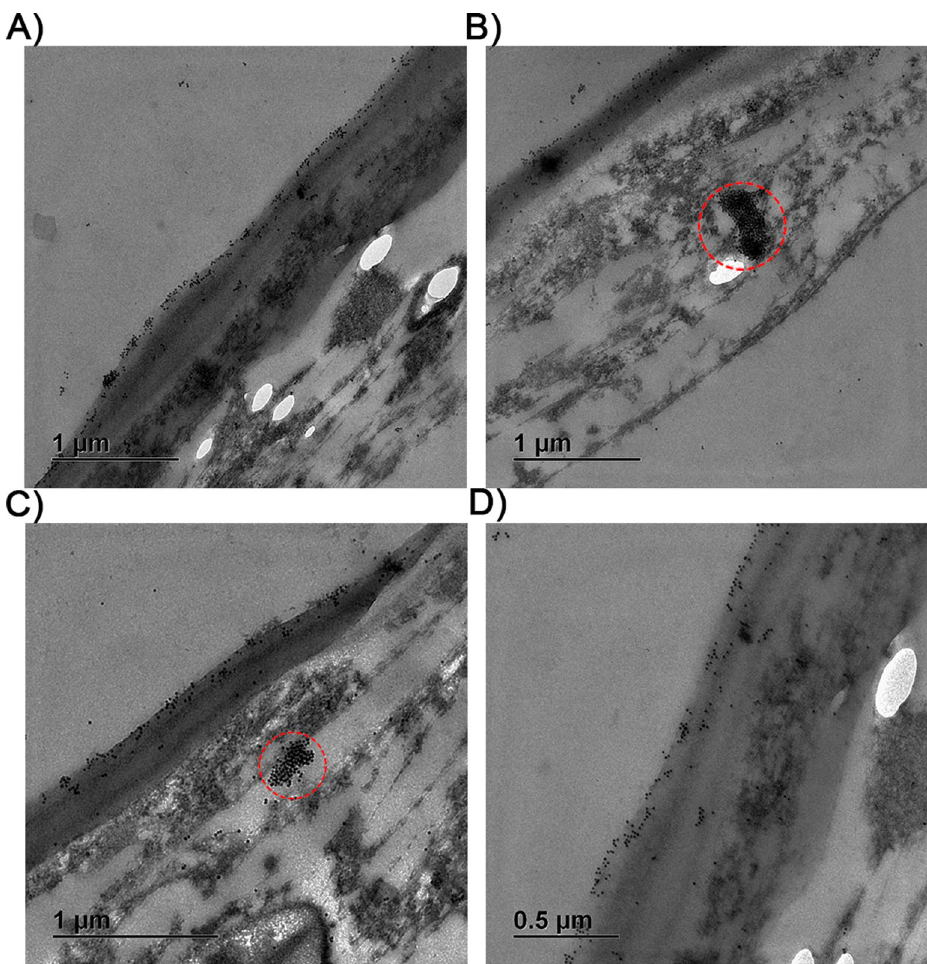
Figure 2. Visualization of Pm AP2-β in YHV-infected hemocytes cell by TEM. Pm AP-2β was detected by a 10 nm gold-conjugated anti-AP-2β antibody. Red circles show clusters of Pm AP2-β form as a